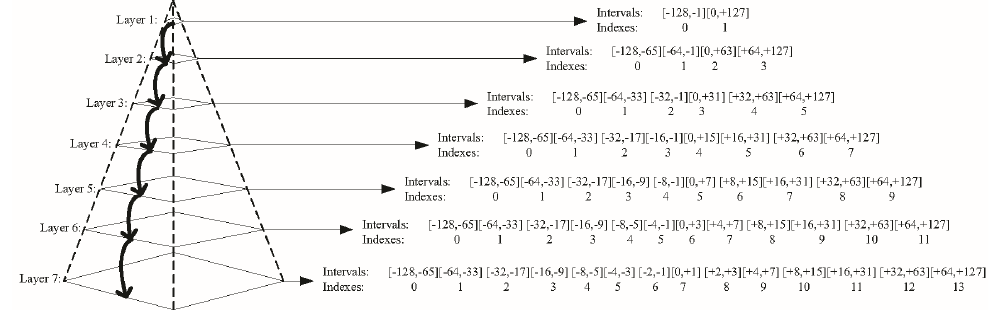
Figure 2. Pyramid color quantization model.